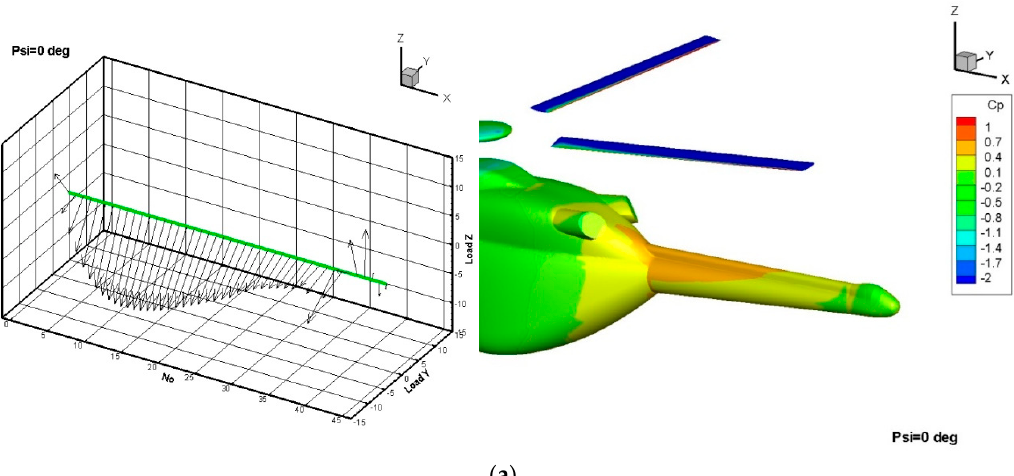
Figure 11. Vertical aerodynamic load on the tail boom, as a function of the azimuth of the main rotor blades.